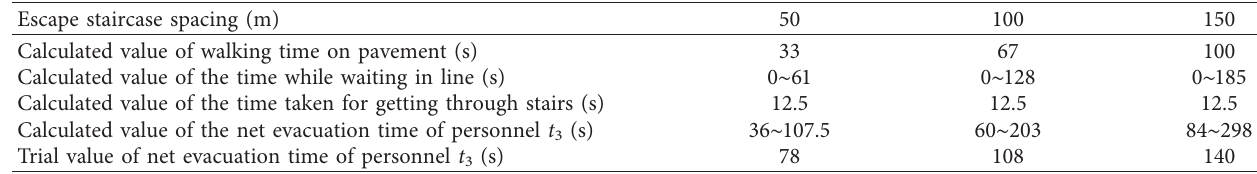
Table 4: Evacuation note time and cumulative evacuation time under different escape staircase spacing.